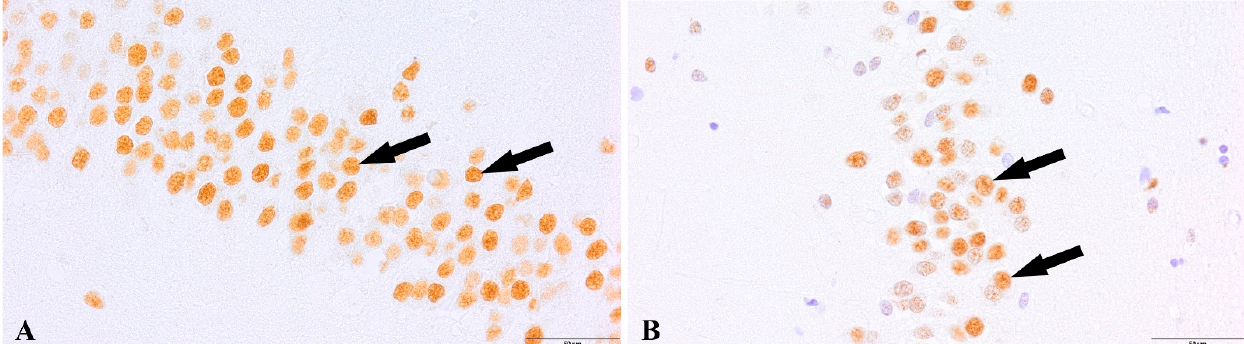
Figure 2. Dentate gyrus, neural progenitor cells (NPCs, arrows). ( A ). Control group. ( B ). Group patients with diagnosed COVID-19. Immunolabeling p-Histone H3Ser10 antibody.